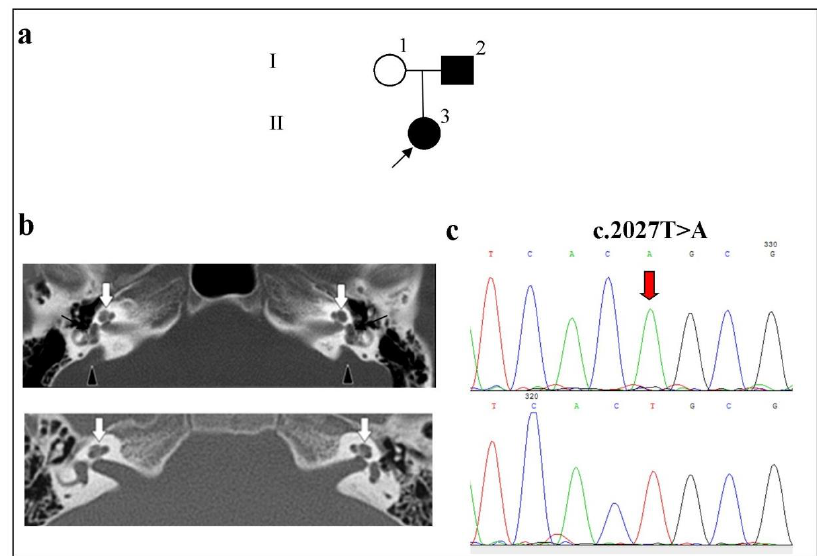
Figure 3. Identification of the c.2027T>A p.(Leu676Gln) variant in the SLC26A4 gene in a homozy- gous state in a patient with bilateral EVA anomalies. Note. ( a ) Pedigree of the patient (the arrow indicates the proband). ( b ) Computed tomography (CT) of the temporal bones in the axial projec- tion. Upper panel: Patient II:3 with a preserved cochlea (white arrows), vestibule dilatation, and bilateral EVA anomalies (triangles indicate the enlarged vestibular aqueduct); lower panel, a patient without anomalies (white arrows). ( c ) Upper panel: a fragment of the chromatogram of the SLC26A4 gene sequence with the c.2027T>A p.(Leu676Gln) variant in a homozygous state; lower panel: the normal sequence.